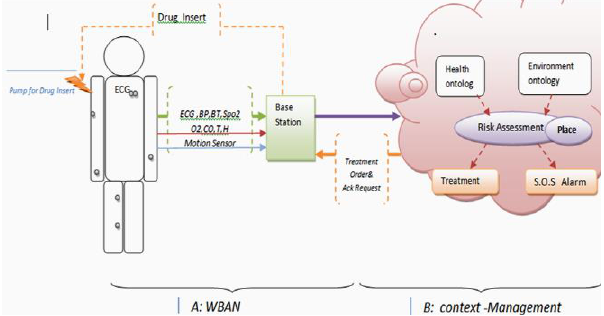
Figure 2.A conceptual model of a defined pervasive computing